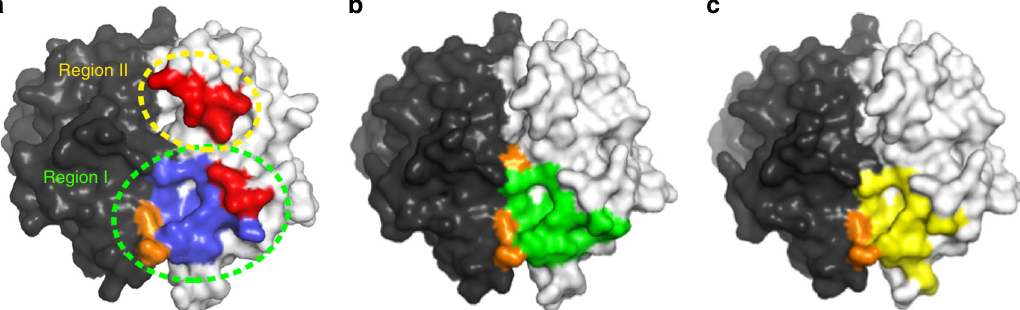
Fig. 3 Comparison of belimumab epitope with receptor-binding sites. a The belimumab epitope on the BAFF surface. Two neighboring BAFF protomers are colored gray and black. The epitope regions for the heavy and light chains of belimumab are colored blue and red, respectively. The epitope region on an adjacent protomer, which is involved in the interaction with the belimumab heavy chain, is colored orange. Regions I and II are indicated as dotted ellipses. b The BR3-binding site is colored green and orange on the BAFF surface. c The BCMA-binding site is colored yellow and orange on the